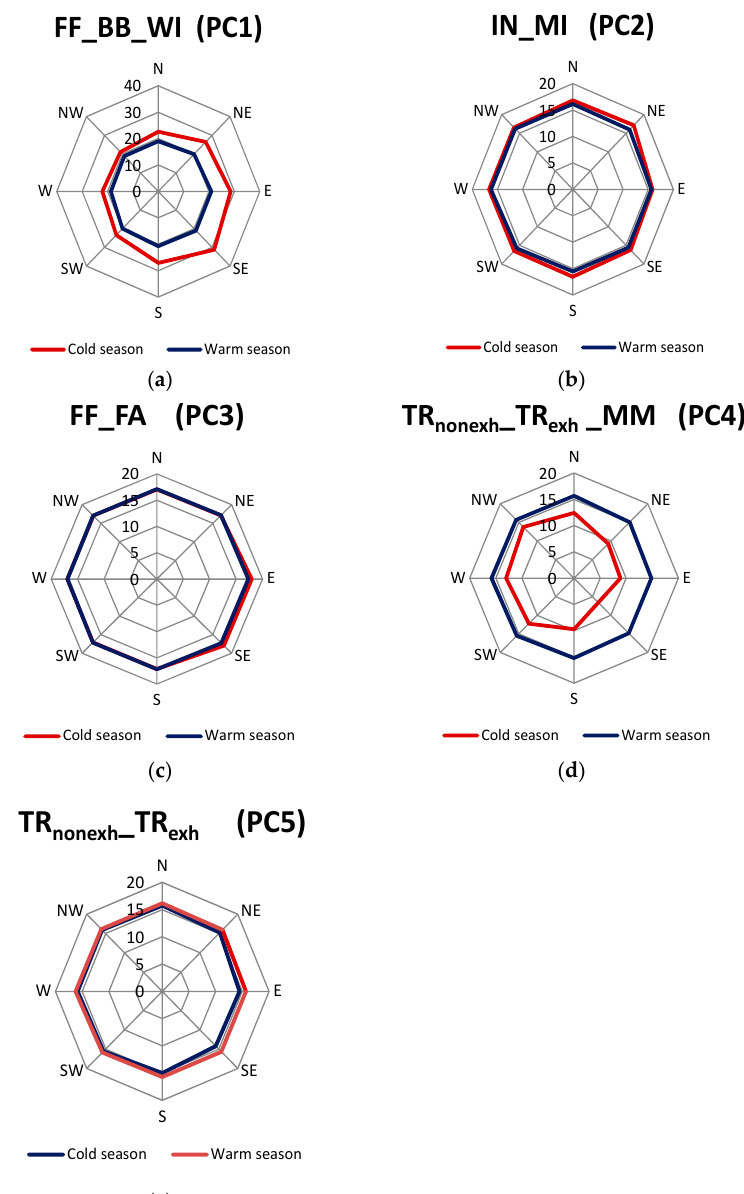
Figure 5. Mean source contributions (%) to PM 2.5 concentrations in the cold/heating season and the warm/non-heating season for the selected air mass inflow directions in Racibórz. ( a ) PC1: fossil fuel combustion (FF)/biomass burning (BB)/waste incineration (WI); ( b ) industrial sources (IN)/metal industry (MI); ( c ) fossil fuel combustion (FF)/fly ash (FA); ( d ) non-exhaust traffic-related sources (TR nonexh )/exhaust traffic-related sources (TR exh )/mineral matter (MM); ( e ) TR nonexh /TR exh . The EFs calculated for each of the 17 elements correlated with PC1 were much higher in the heating season than in the non-heating season (Figure 2), which indicates that the PC1 must have been correctly identified as FF_BB_WI. It can therefore be suspected that a stronger anthropogenic influence on the concentrations of the 17 elements during the heating season is a result of a more intensive emission from FF_BB_WI. It must be noted, however, that the mean value of EF for some